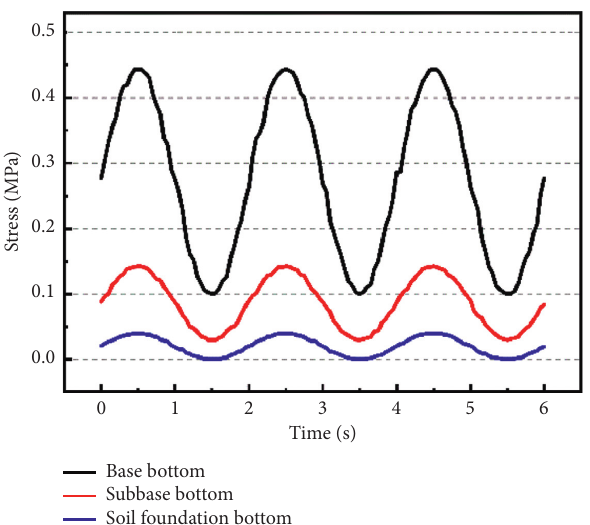
Figure 17: Typical dynamic load response rule of the pavement structure.